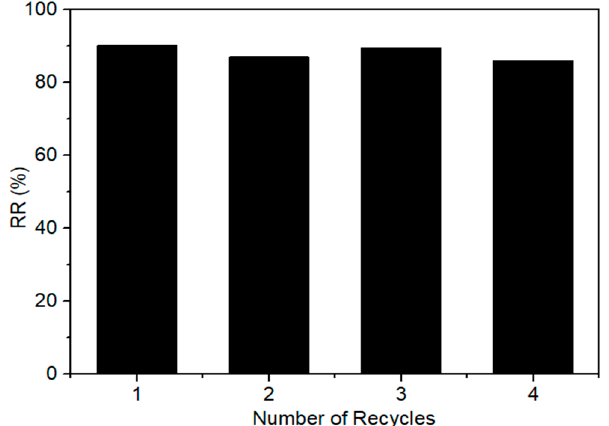
Figure 9. The recyclability of the P-POPs for the removal of tetracycline. Reaction conditions: 20 mg/L tetracycline solution 40 mL, P-POPs-3 10 mg, dark reaction 0.5 h, light reaction 6 h.